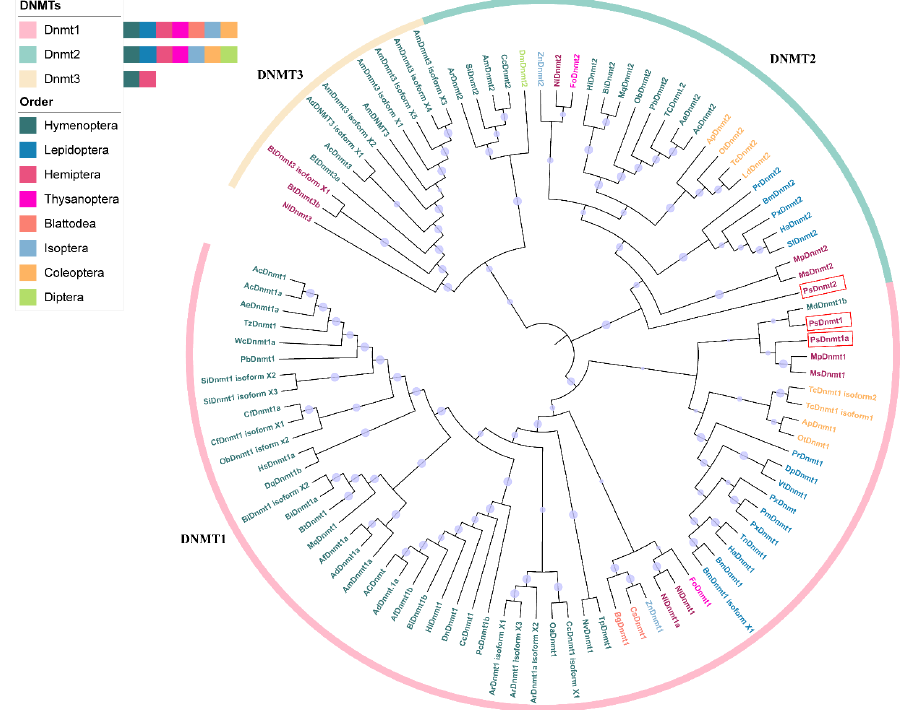
Figure 1. Phylogenetic analysis of the DNMT protein families (1, 2, and 3) across different insect orders. One-hundred-and-three amino acid sequences from eight insect orders were used to construct this tree using the Maximum Likelihood method. Different colored parts of the circle represent the different DNMT types, and the different insect orders are also color-coded. The sequences of proteins from the cotton mealybug, P. solenopsis , are enclosed in red boxes.